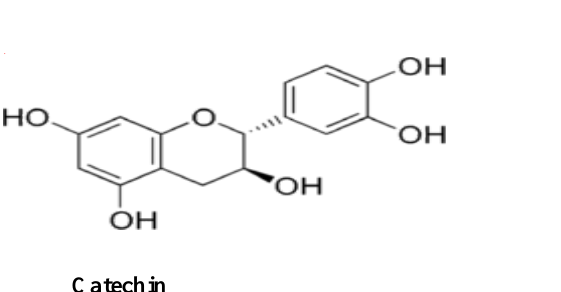
Figure 6 . Chemical Structure of catechin and epigallocatechin Identification of isolated compound by the spectroscopic